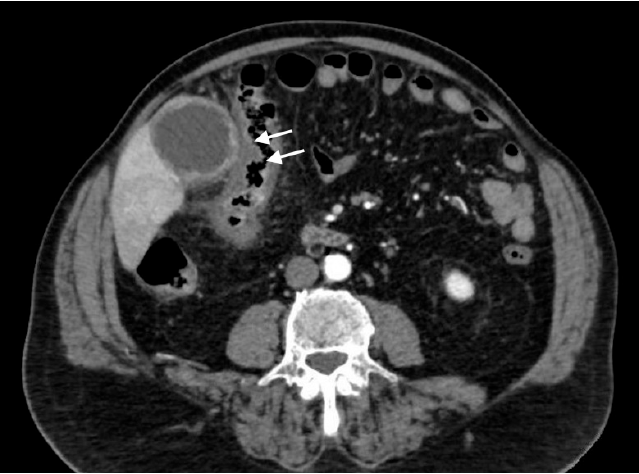
Figure 13. Gangrenous cholecystitis with colitis: axial scan shows the signs of pericholecystic in- flammation that extend to the right colic flexure with diffuse colic wall thickening (white arrows).